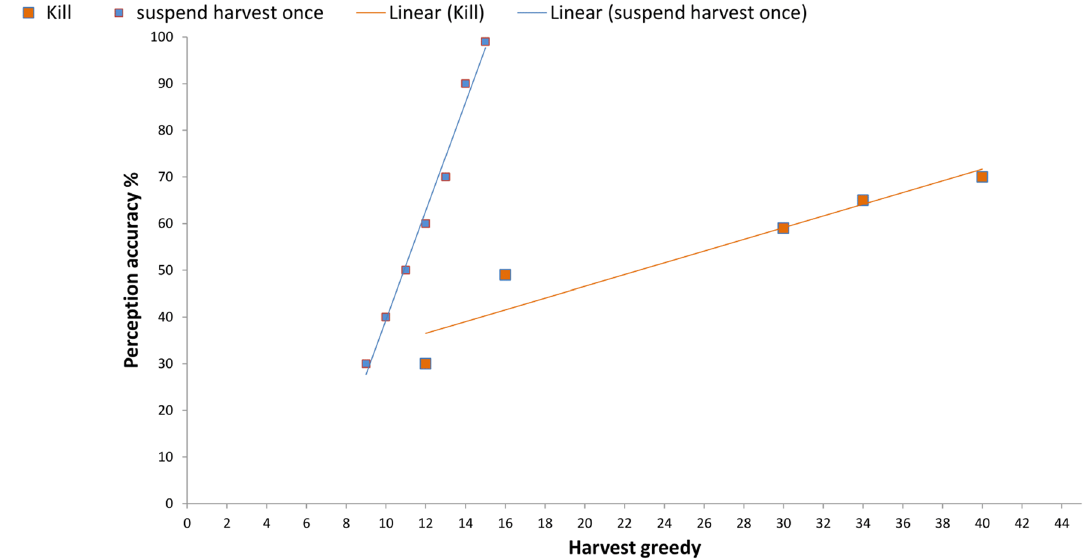
Figure 5. A strong positive correlation between the variables (harvest greed and perception accuracy) through different punishment types: (1) The first type, "suspend harvest once" (small blue squares). The second type, "pay fine", is the same. (2) The third type "kill" (large orange squares). (3) The blue line is the linear relationship of the selected values through the first/second type of punishment. (4) The orange line is the linear relationship of the selected values through the third type of